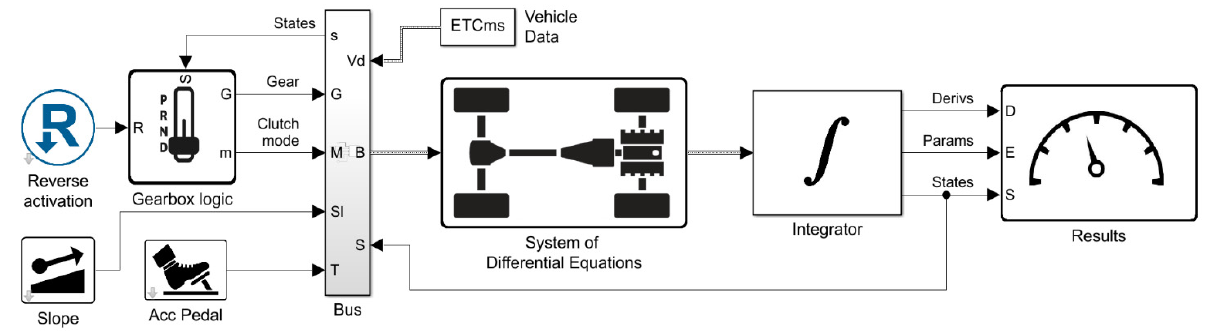
Figure 7. Simulink model of translational vehicle dynamics. Table 1. The summary table of data accepted for the model, in the order of their appearance.